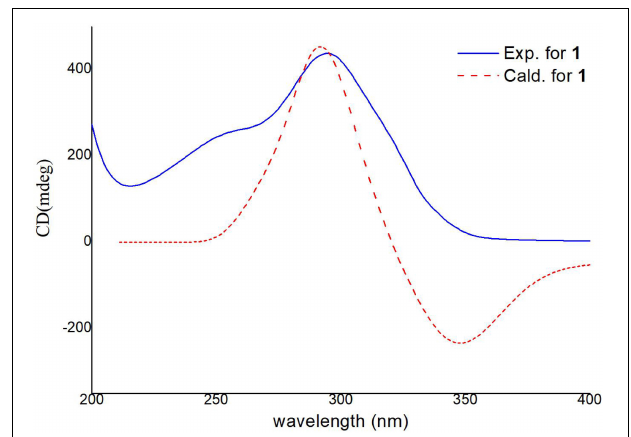
FIGURE 4 | Experimental and calculated ECD spectra of compound 1 (calcd. ECD curves with a bathochromic shift for 20